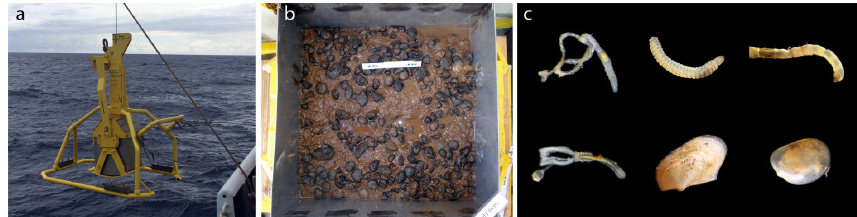
Illustrated is a range of macrofaunal taxa typically less than 1 mm in size collected with box core on the recent ABYSSLINE program to the eastern CCZ ( c